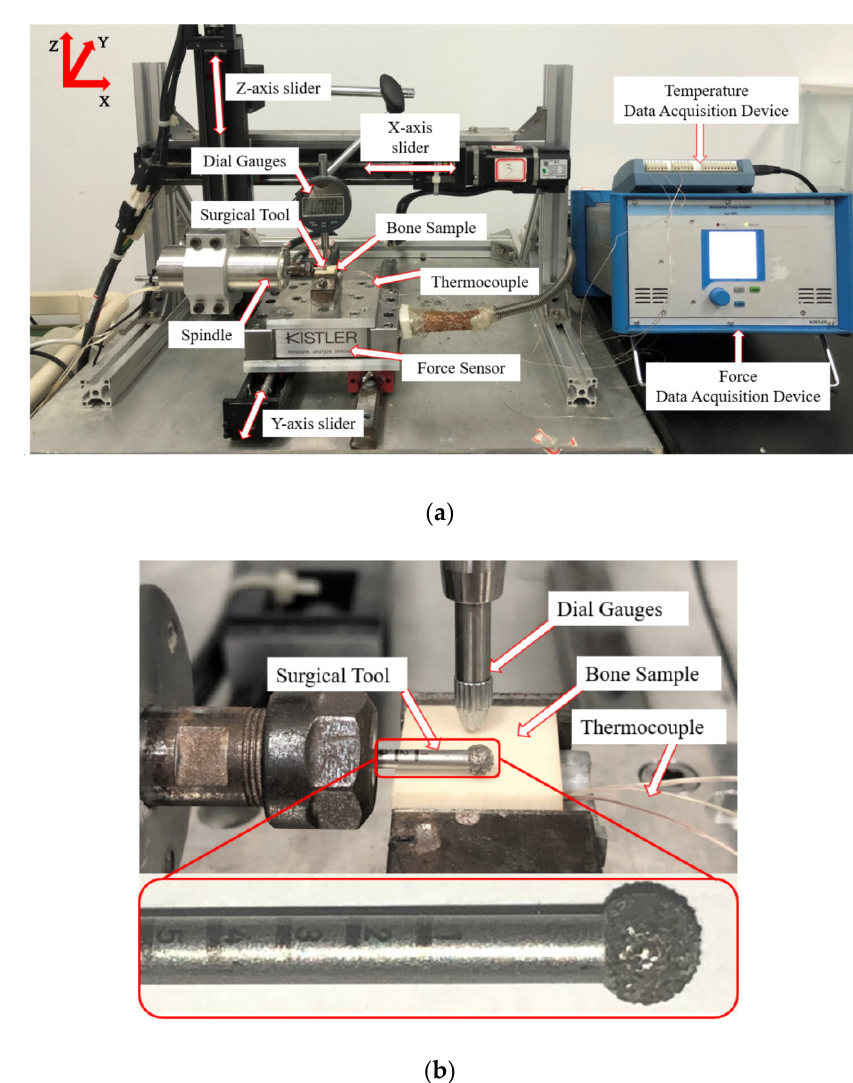
Figure 3. Photographs of the ( a ) overall experimental setup and a ( b ) close-view of the grinding wheel and workpiece.